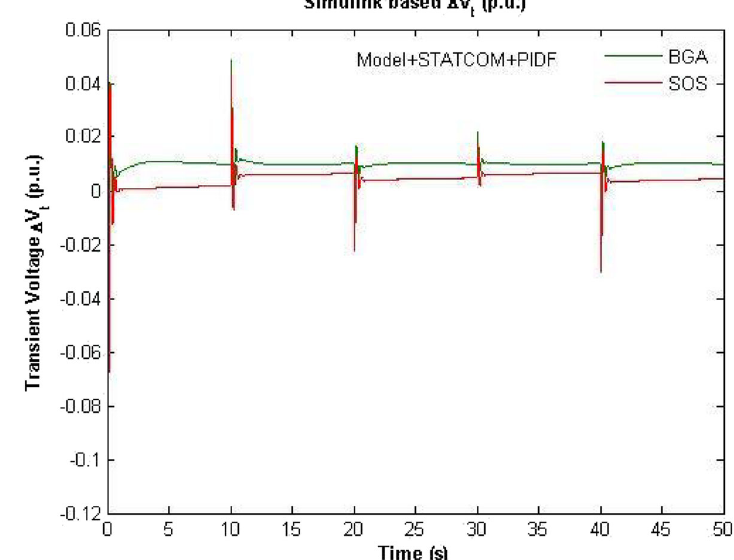
Fig. 7 Transient voltage graph under V = 1.0 p.u. and Xeq = 0.93 p.u. in presence of variable